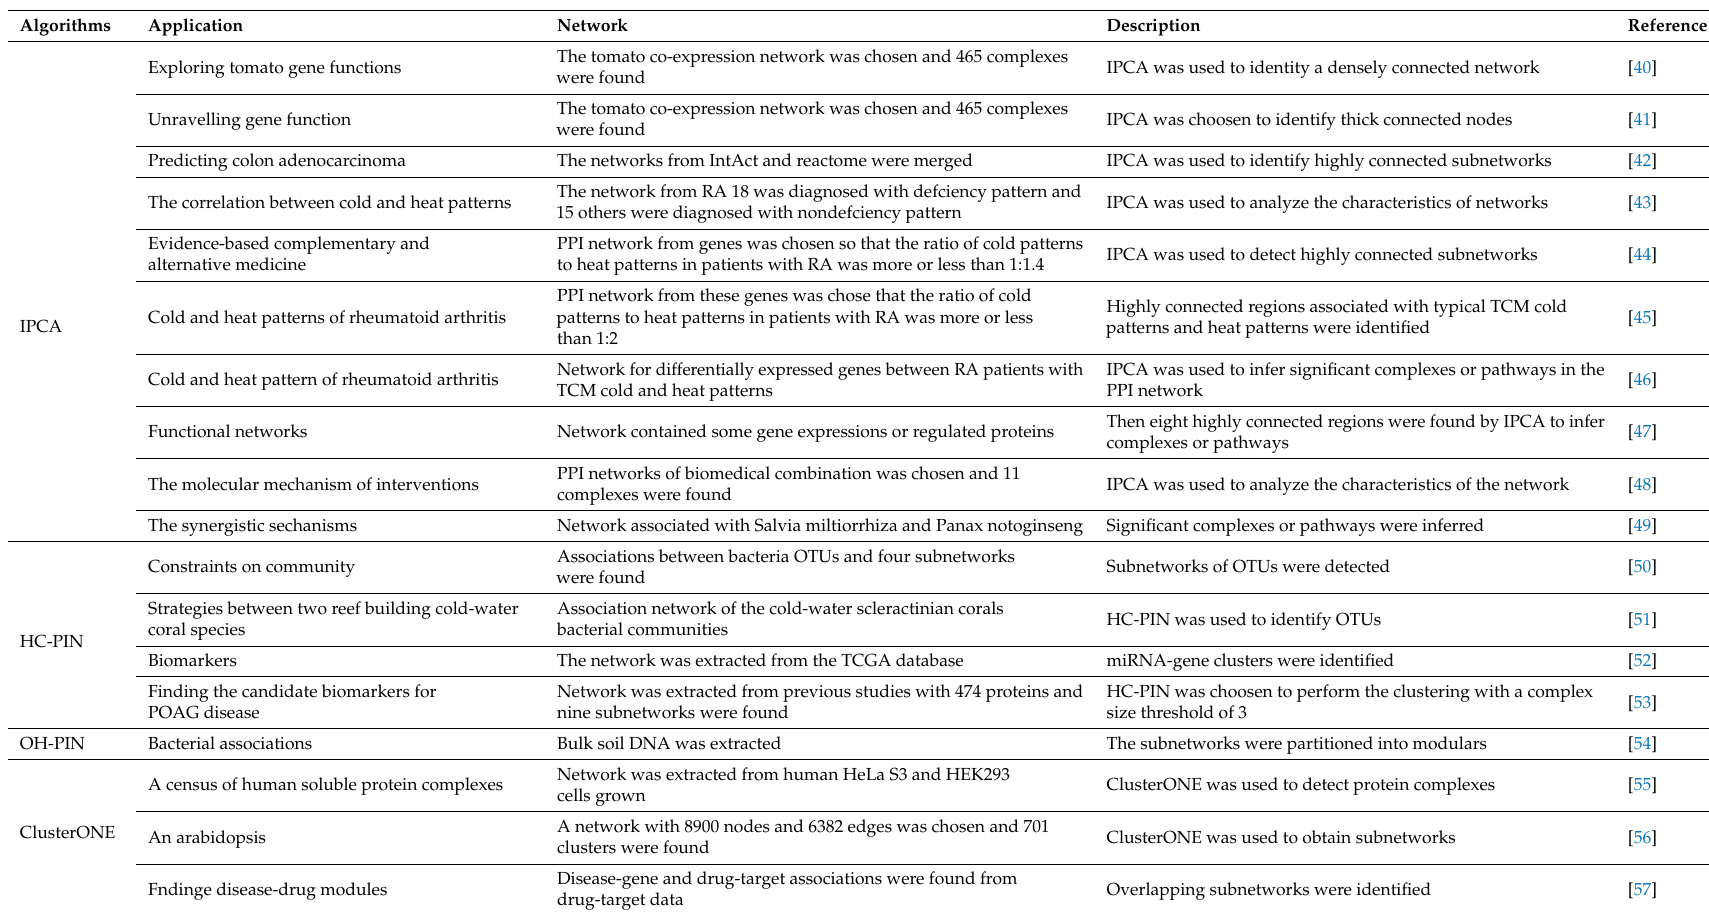
Table 1. More applications of CytoCluster and the six clustering algorithms integrated in